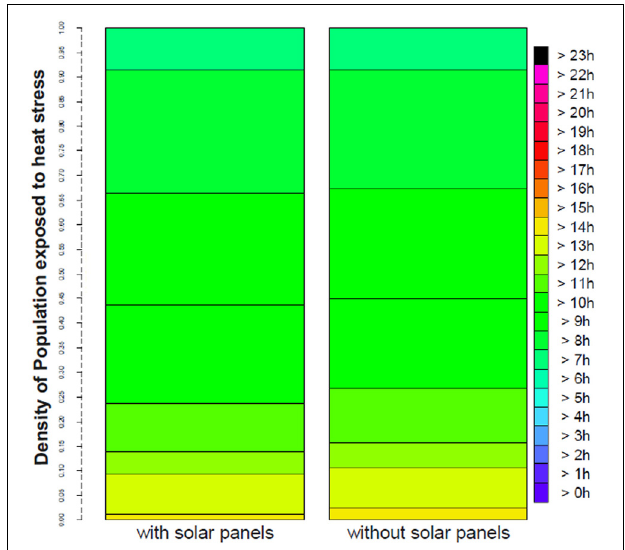
FIGURE 4 | Population exposed to moderate heat stress in August 2003 (monthly average). Left: with solar panels. Right: without solar panels. The figure reads this way: 100% of the population is affected by at least 7h of heat stress per day, but only a few percents (in yellow) by more than 14h of heat stress per